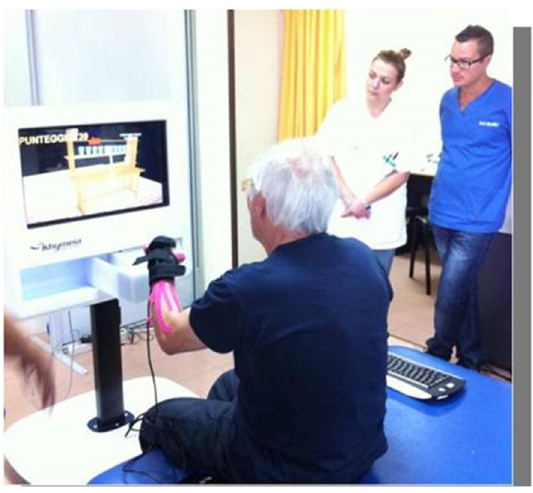
Figure 2. Shows the “3D” interaction modality (through the sensors located over the upper